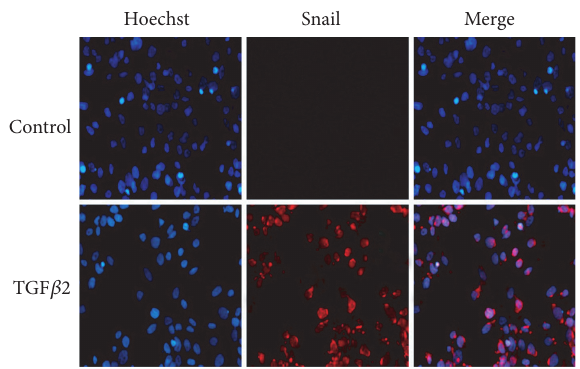
Figure 3: TGF 𝛽 2-induced expression of Snail protein. HLEB3 cells were incubated in the absence or presence of 10ng/mL TGF 𝛽 2. After8hoursofculture,cellswereimmunofluorescencestainedwith anti-Snail antibody (red) and counterstained with Hoechst (blue). Snail were expressed after TGF 𝛽 2 treatment and located in nuclear (400x).